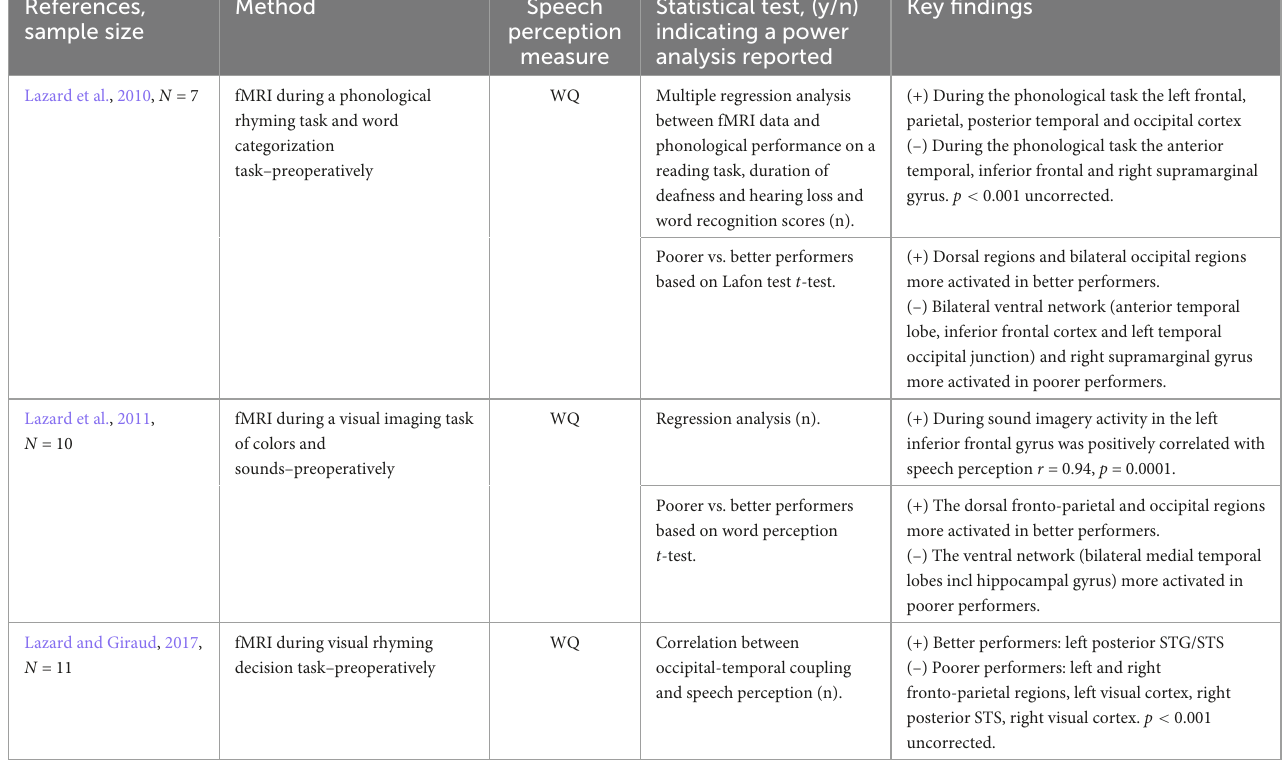
TABLE 3 Overview of included papers studying brain activation during mental auditory